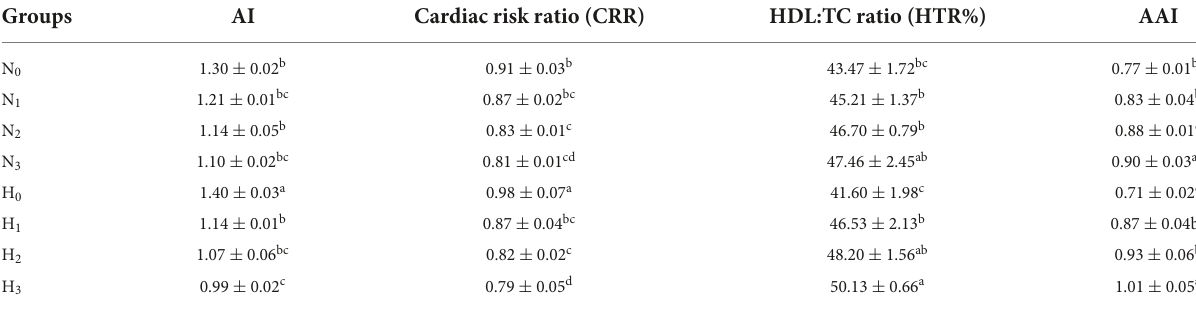
TABLE 4 Lipidemic ratio of rats treated with different curcumin-enriched diets.